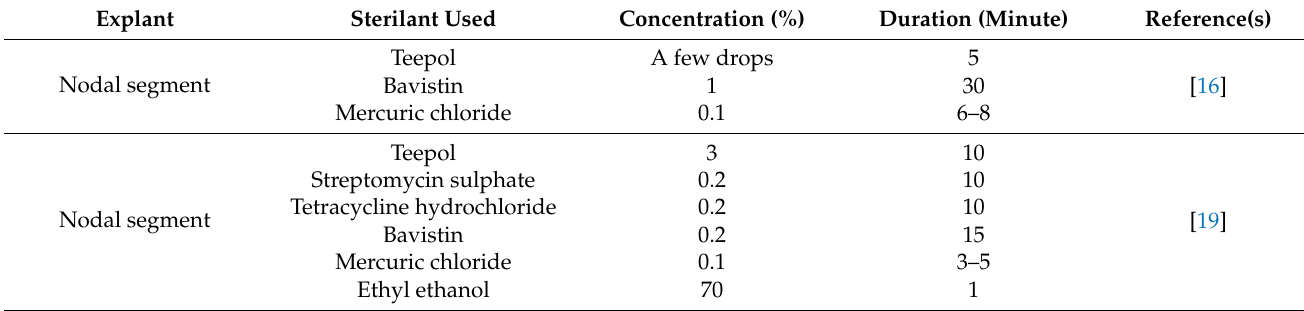
Table 3. List of sterilants used for different explants in D. asper